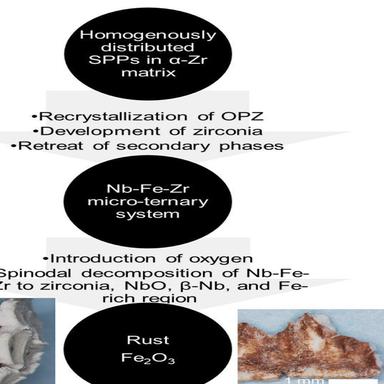
Steps of formation material degradation leading to the development of iron (III) oxide in uncoated OPZ.